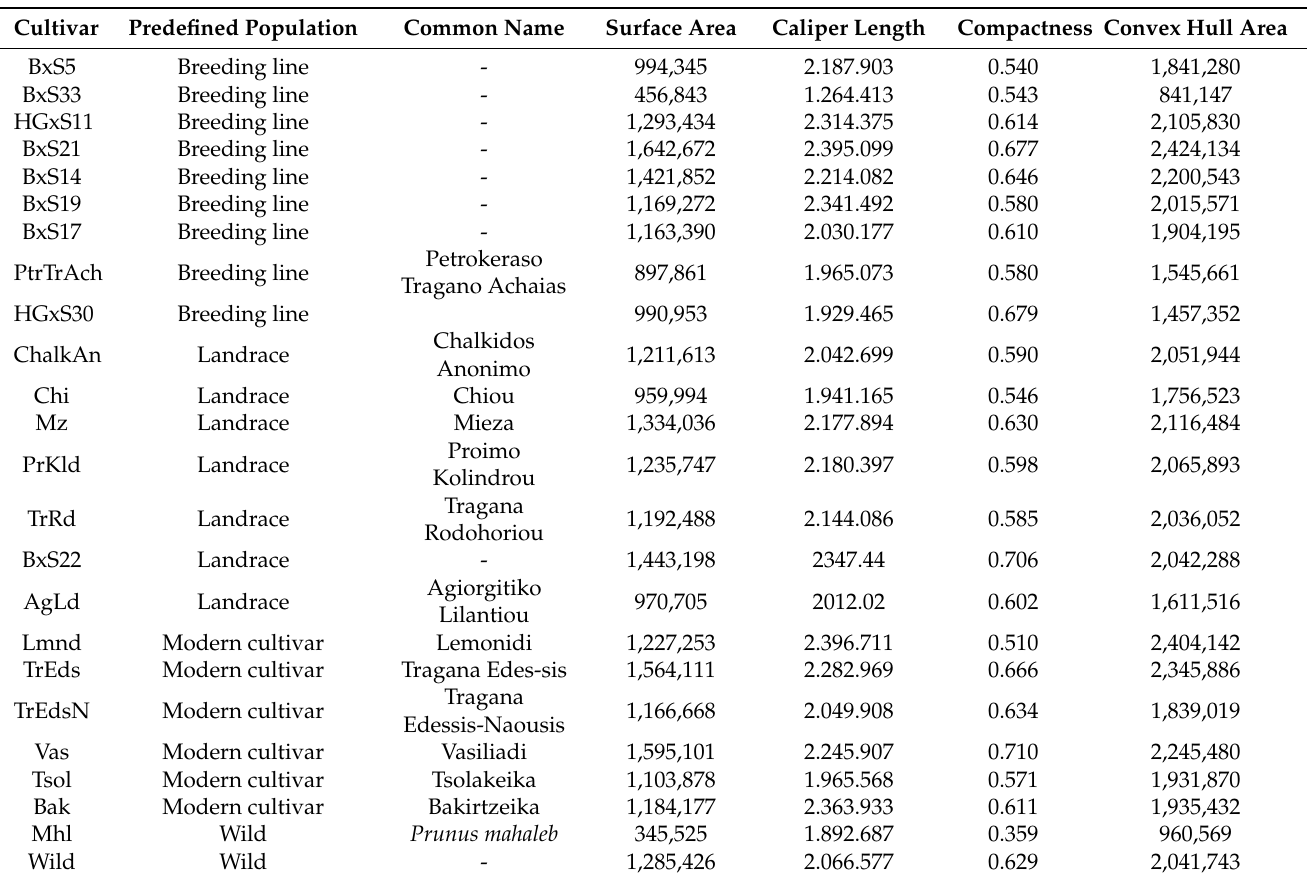
Table 1. Leaf parameters for 24 sweet cherry